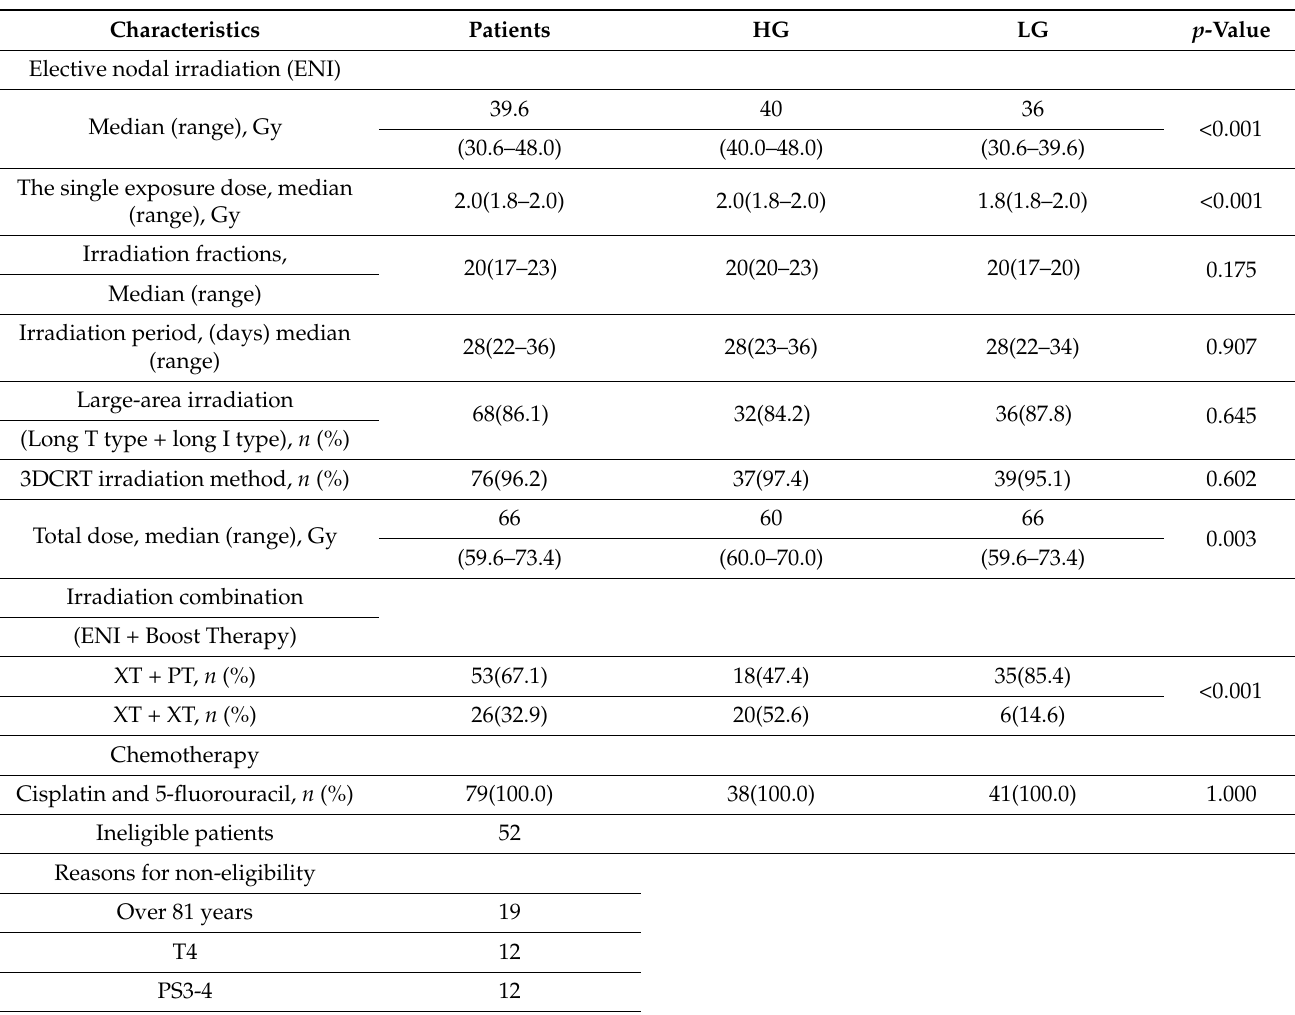
Table 2. Characteristics of the treatment